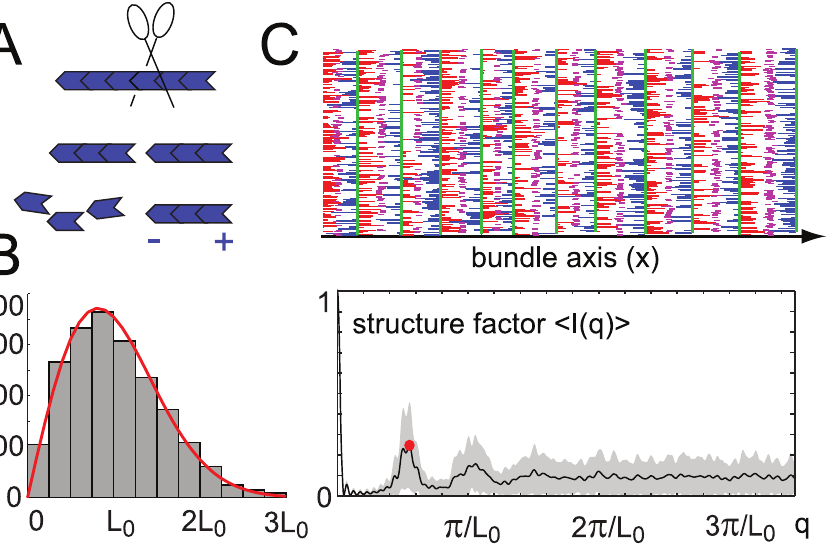
Figure 6. Actin filament length control by severing. A. Filament severing provides a simple physical mechanism for actin filament length control, see main text. In an idealized scenario, an actin filament (blue) binds a severing agent (scissors) with a rate a L that is proportional to its length L at a random position. The filament is then cut at the binding position, and its minus-end facing fragment is subsequently depolymerized. B. Actin filament severing results in a unimodular filament length distribution at steady state, see histrogram (gray) and analytical expression (red, see SI , mean filament length S L T ~ 1 : 02 L 0 , and filament length variability parameter, n ~ 0 : 52 . C. text S1). For the severing rate used, a ~ 1 : 5 v 0 = L 2 0 Simulation of an acto-myosin bundle as in figure 3, but with actin filament severing as described in panel A. Shown is a snap-shot of the simulations at time t ~ 50 (actin filaments: blue and red; myosin: magenta; end-tracking crosslinker: green), as well as the averaged structure factor (black curve, gray region indicates mean + s.e., n ~ 100